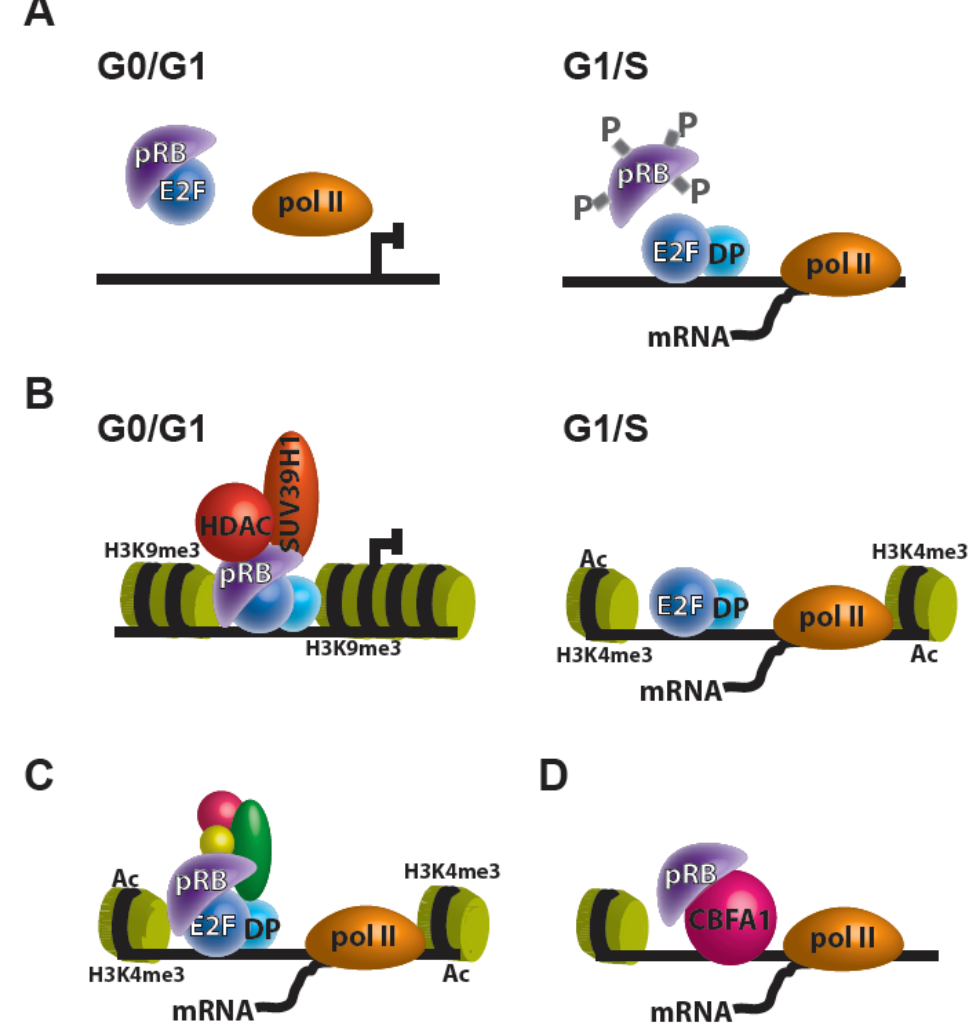
Figure 1. Transcriptional regulation by pRB. ( A – C ) The pRB can regulate E2F targets in at least three di ff erent mechanisms: ( A ) direct pRB repression on E2F transcription; ( B ) pRB recruitment of transcriptional corepressors, like HDACs and histone methyltransferases (e.g., SUV39H1) to E2F targets; and ( C ) association of the pRB-E2F complex with transcriptional coactivators, which results in increased expression of E2F targets. ( D ) pRB can regulate transcription through its interaction with